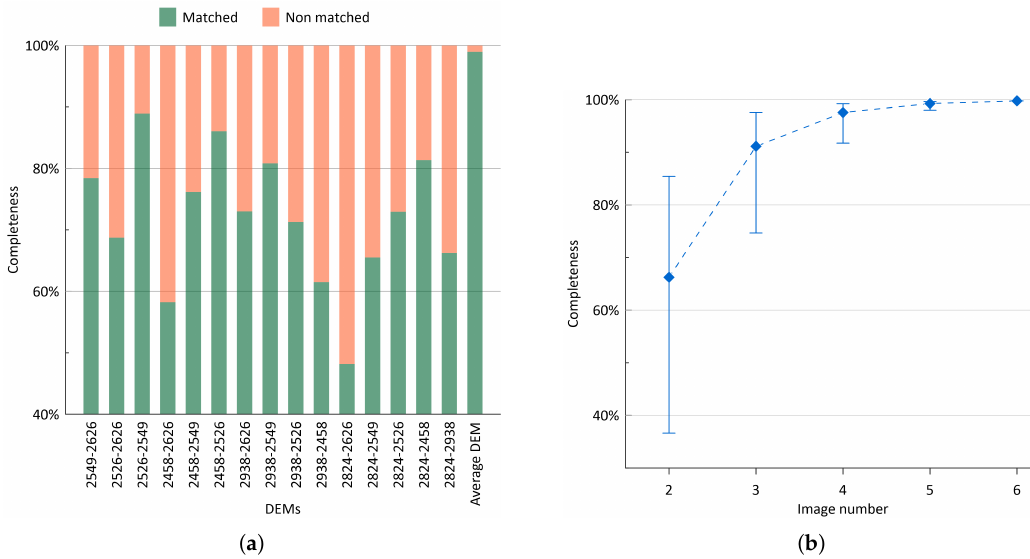
Figure 4. ( a ) completeness of the entire DEMs derived from each pair and of the Average DEM; ( b ) completeness variation with the number of images available for the Centre